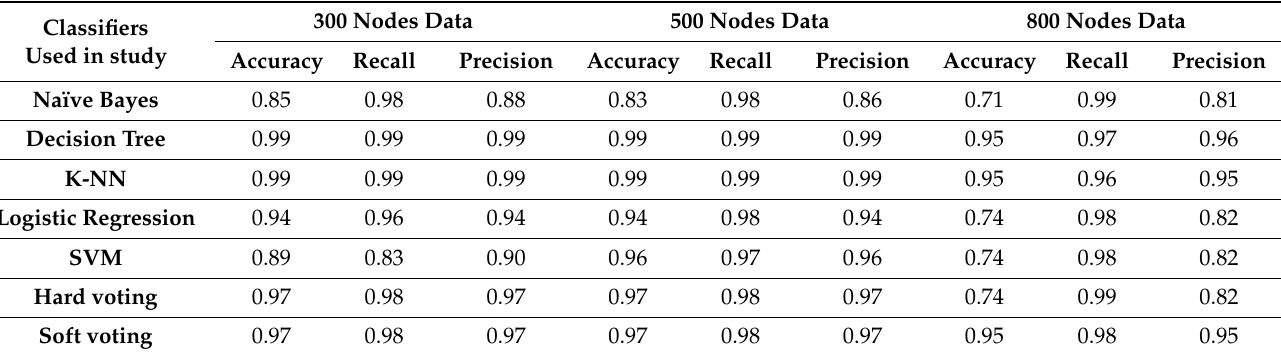
Table 4. Results of proposed Majority Voting Technique (Hard and